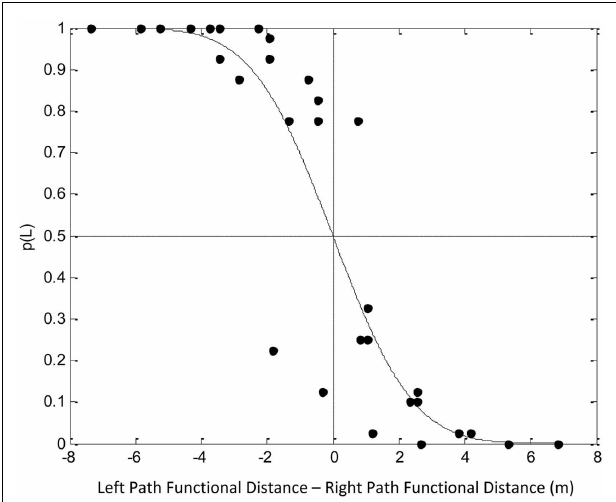
FIGURE 13 | Probability, p ( L ), of choosing to walk along the left side of the table (Rosenbaum, 2012). Left path functional distance was defined as walking distance + 10.3 × right-hand reaching distance . Right path functional distance was defined as walking distance + 12.3 × left-hand reaching distance, all in meters (m). Adapted from Rosenbaum